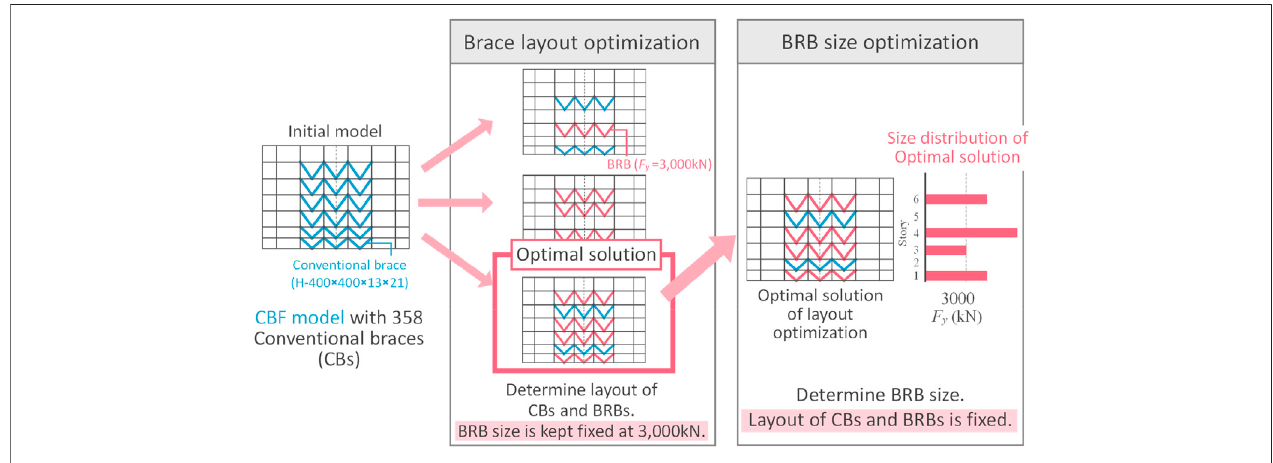
FIGURE 6 | Schematic overview of the GRSA-based seismic